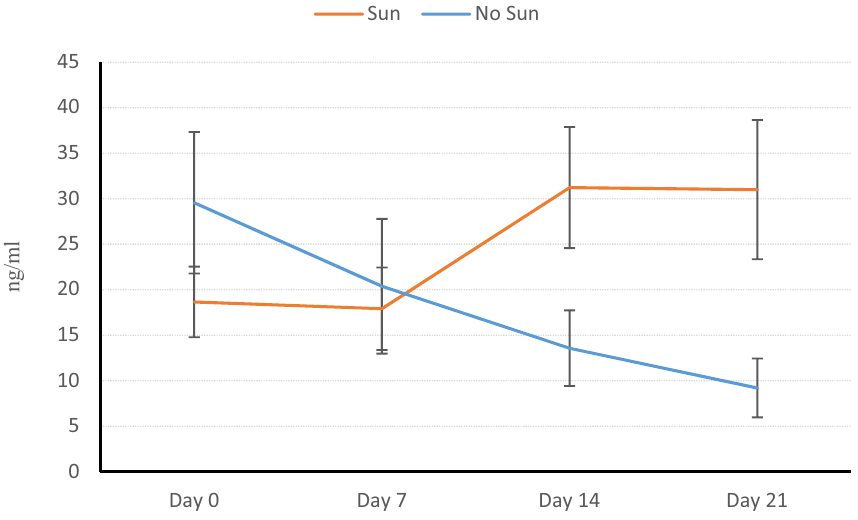
Figure 2. The effects of sun on 25D 3 . The 25D 3 Variations in groups A + B (exposed to sun) and C + D (Non- exposed to sun) before Cholecalciferol injection (from Day zero to Day